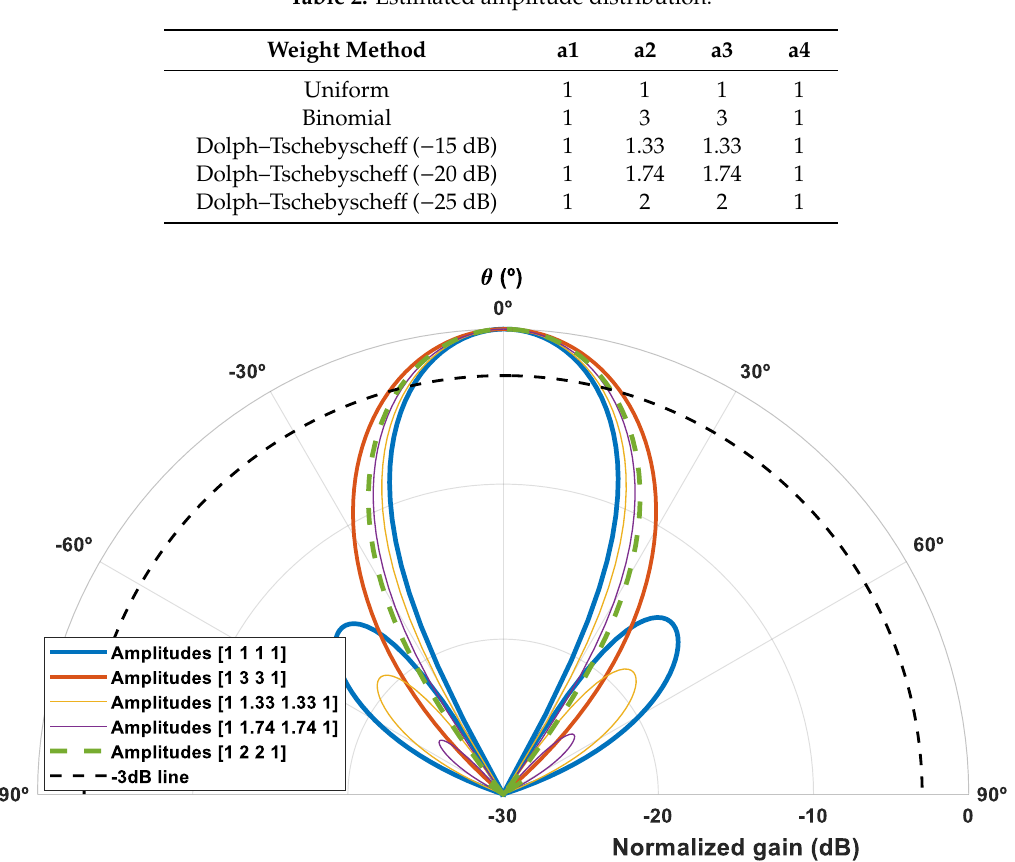
Figure 11. Theoretical radiation patterns considering the distribution weights.